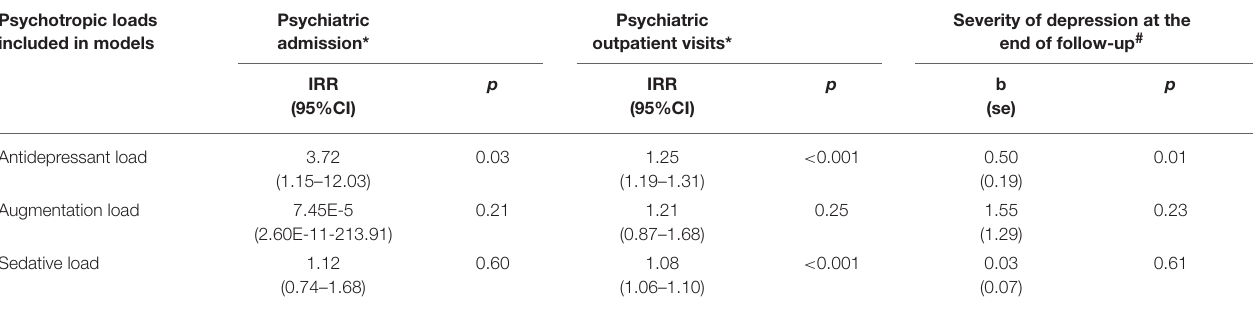
TABLE 4 | Multiple regression analyses for the relationship between categories of psychotropic dissection and clinical features beyond 2-year of disease onset. Psychotropic loads included in